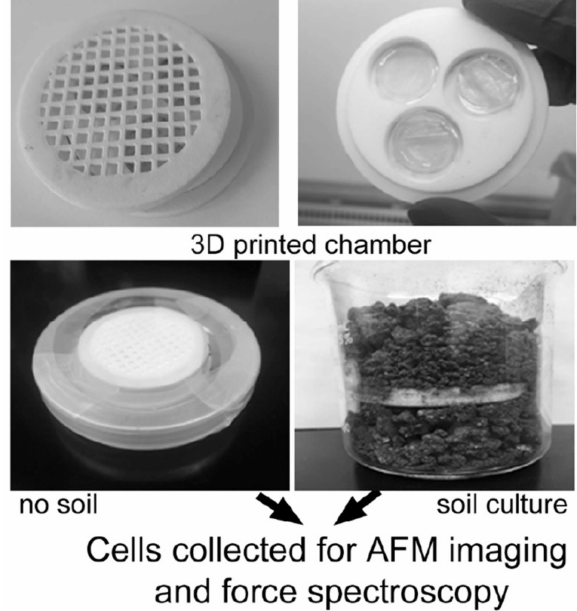
Figure 1. The 3D printed cell culture incubation chamber used to investigate culture of Yersinia pestis under controlled environments. After streaking cells onto each of three separate agar plugs within chamber, parafilm is used to seal and chamber is placed into either no soil or soil conditions, and allowed to grow for 48 h at 30 ◦